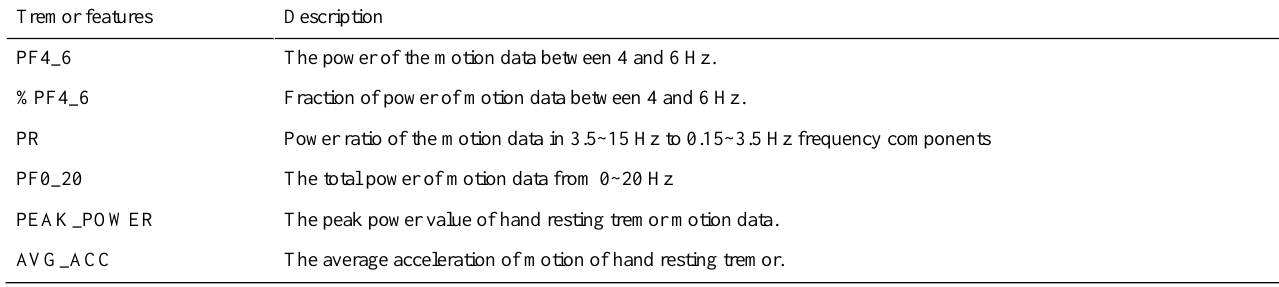
Table 2. Extracted hand resting tremor motion features.